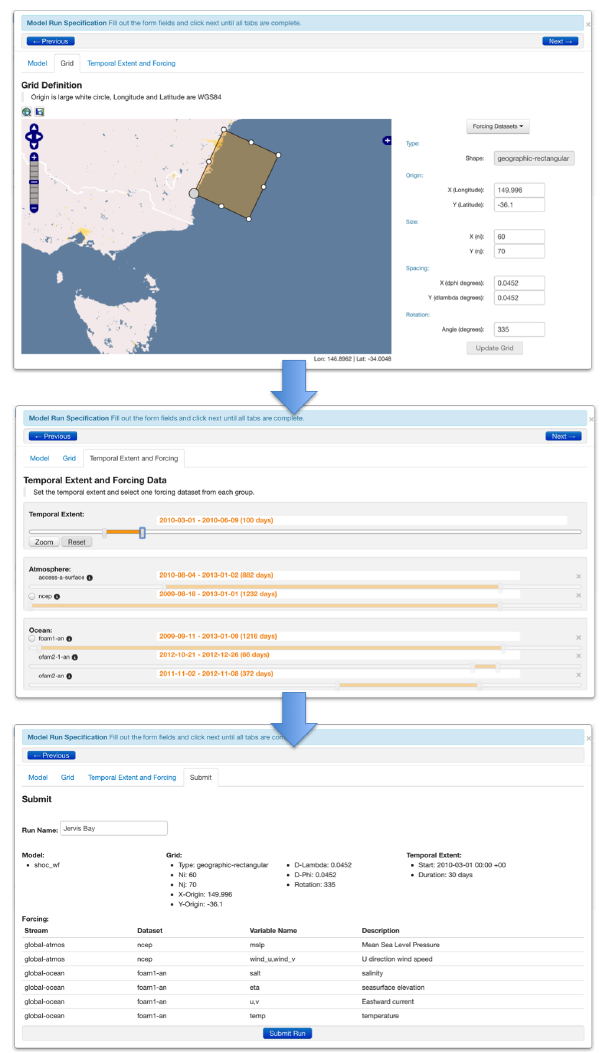
Figure 3. Screenshots of WebMARVL showing the steps of (top to bottom) configuring a grid, setting the temporal extent and selecting input data, and submitting a